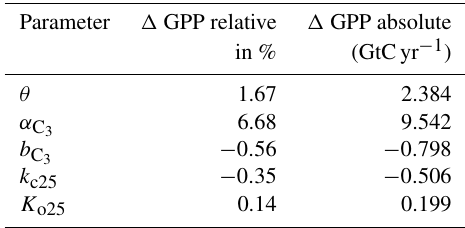
Table 1. Change in the AGPP after varying the listed parameters by 10%. GPP is calculated as the global average mean for the years 1901–2000. Parameter (cid:49) GPP relative (cid:49) GPP absolute in % (GtCyr − 1 ) θ 1.67 2.384 α C 6.68 9.542 3 − 0 . 56 − 0 . 798 b C 3 k c25 − 0 . 35 − 0 . 506 K o25 0.14